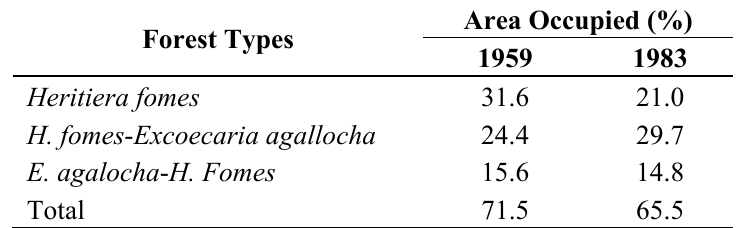
Table 4. Changes of forest types in the BSMF in 1959 [34] and 1983 [14].